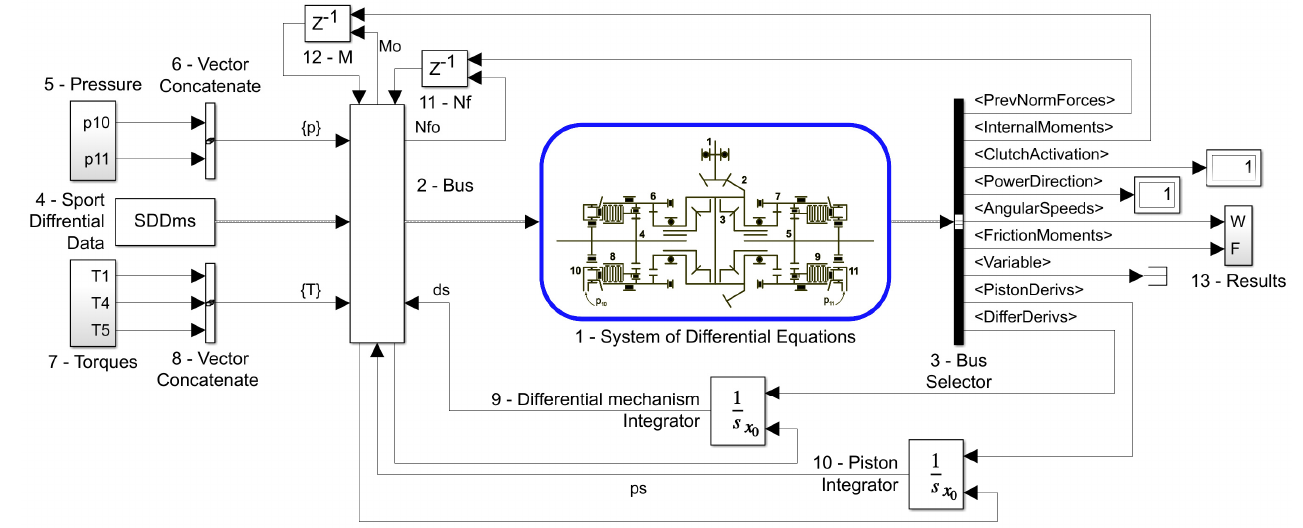
Figure 6. Simulink-model of the sport differential functioning.